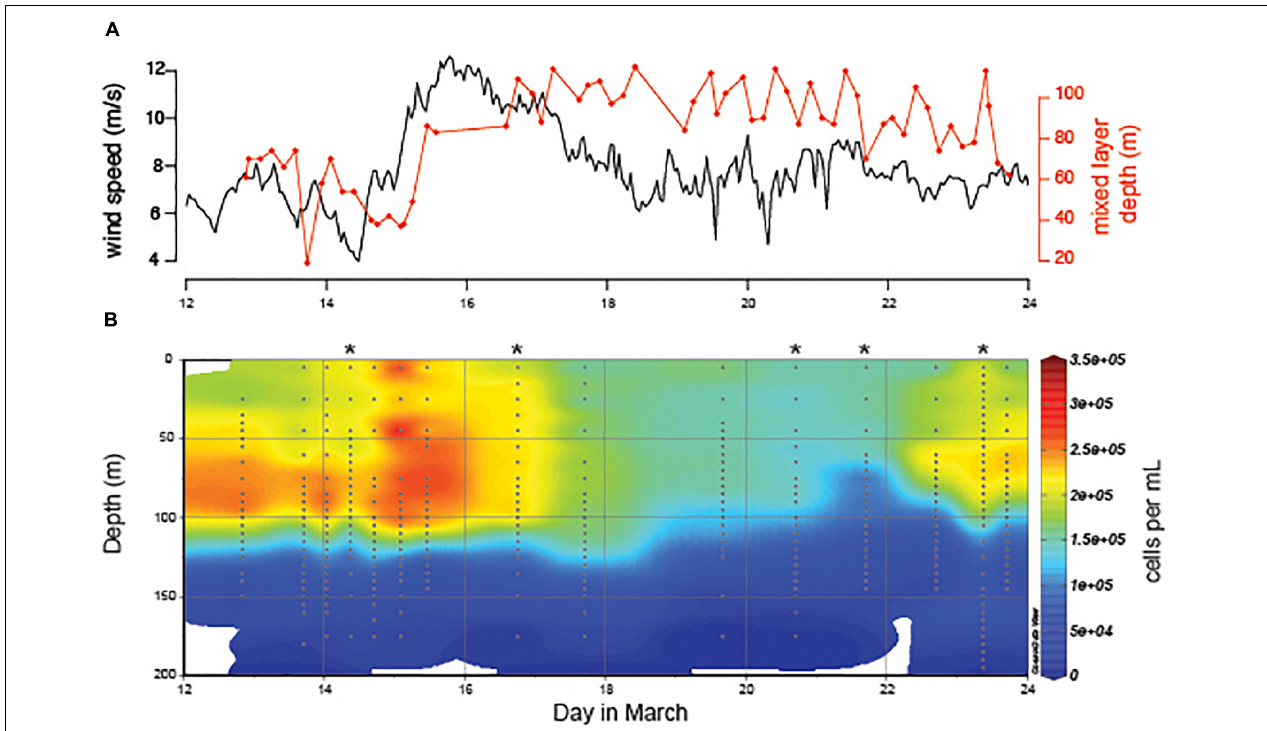
FIGURE 1 | (A) Water column properties at Station ALOHA in response to a peak in wind speed (black) and deepening of the mixed layer (red). (B) Prochlorococcus abundance over the 2-week time-course. Depth profiles with accompanying ecotype abundance data ( Figure 2 ) are marked with asterisks. All depth profiles have accompanying single cell chlorophyll distribution data presented in van den Engh et al.